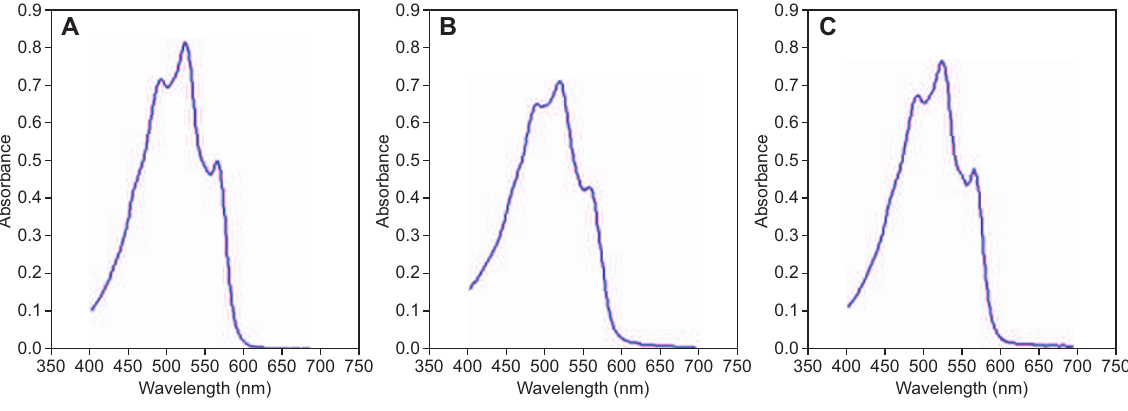
Figure 2 Spectra obtained from the dilute shikonin derivative solutions: (A) deoxyshikonin, (B) β , β -dimethylacrylshikonin, (C) acetyl shikonin.